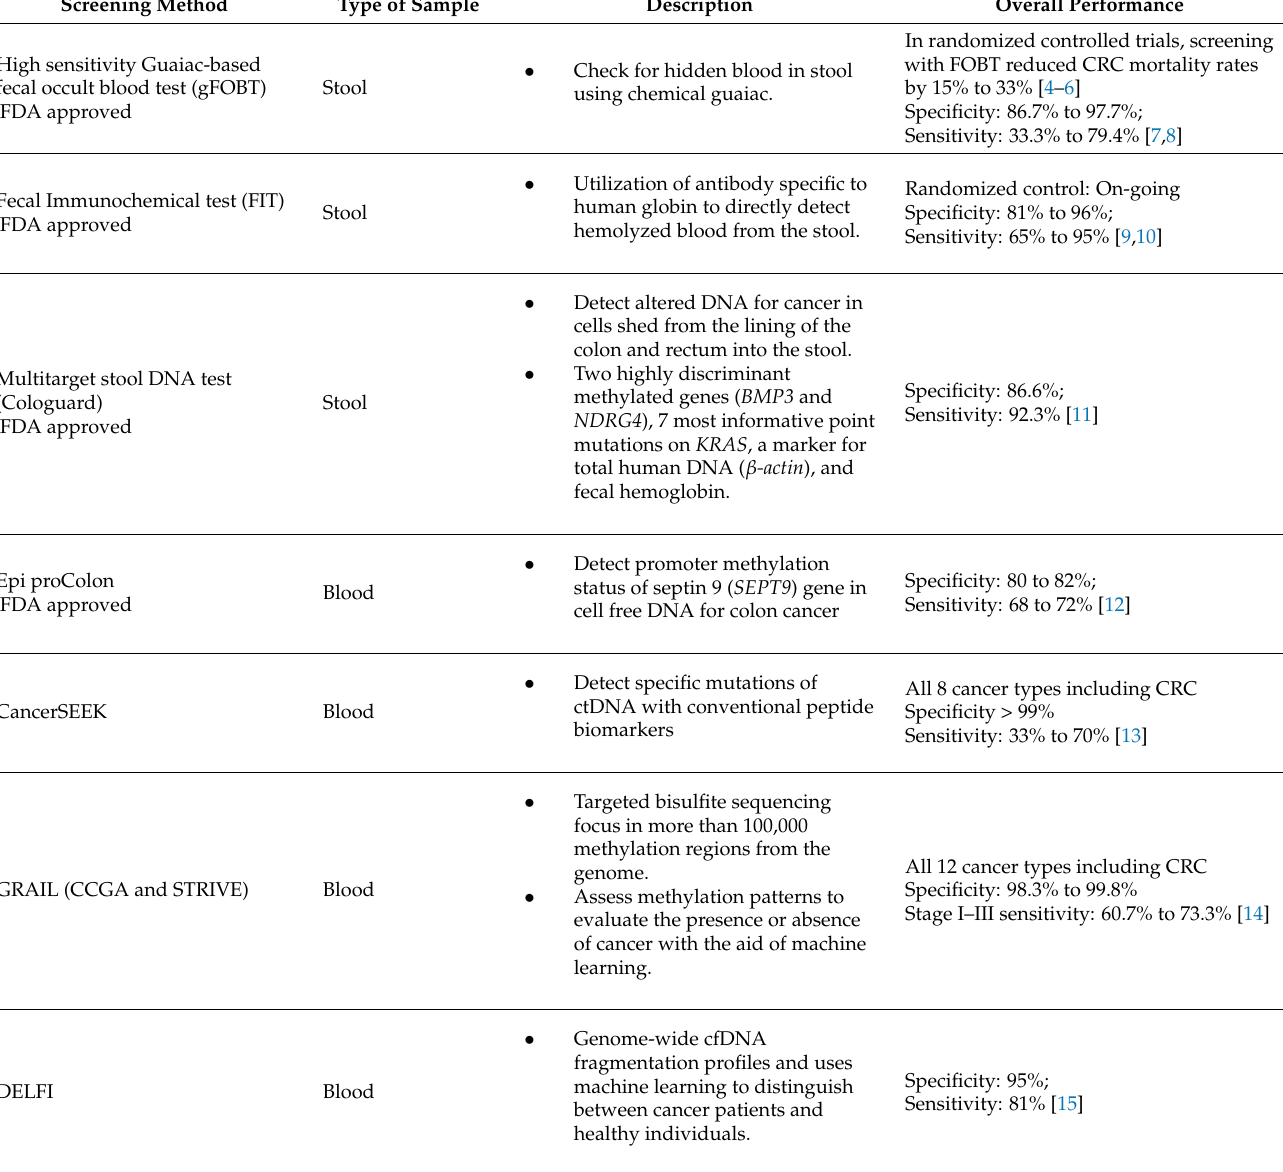
Table 1. Up-to-date stool- and blood-based screening method. Screening